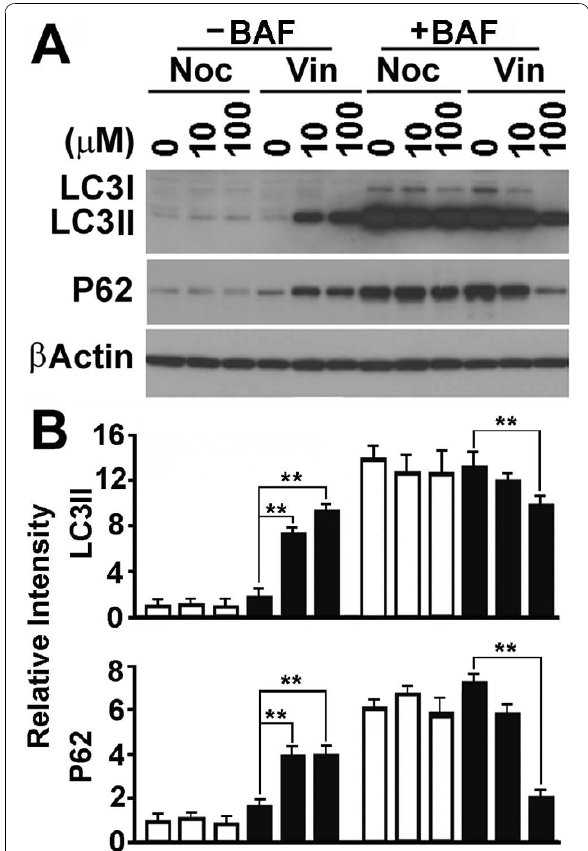
Figure 5 Only vinblastine causes a blockade of LC3II and P62 degradation . ( A ) A representative immunoblot of lysates of HeLa cells treated with different concentration of drugs in the absence or presence of lysosomal inhibitor bafilomycin A1 overnight. P62, P62 (SQSTM1). ( B ) Plots of the relative intensity of LC3II and P62 bands detected from three independent blots as represented by the one shown in (A). **, p < 0.01 as calculated by Student ’ s